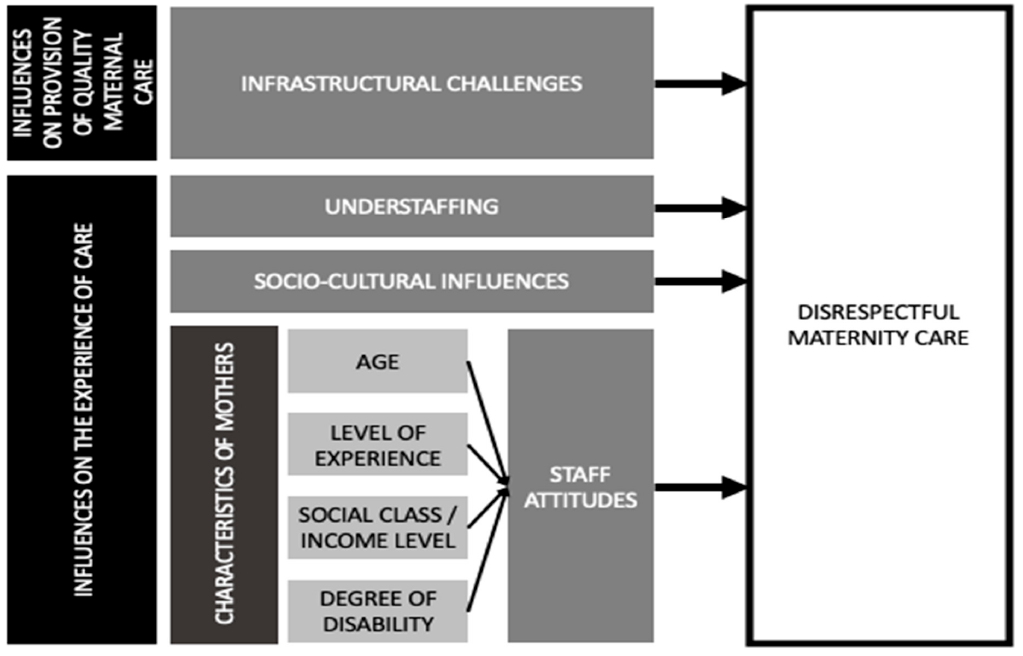
Figure 2. Conceptual framework to understand the influences of health care workers’ (HCWs’) disrespectful maternity